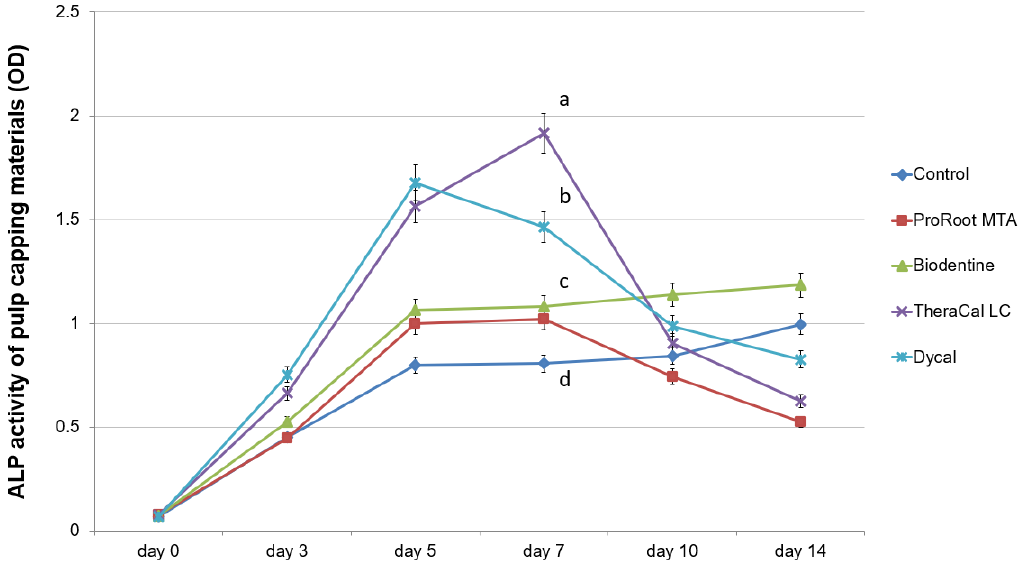
Figure 4. Determination of alkaline phosphatase enzyme (ALP) activity of various pulp capping materials.